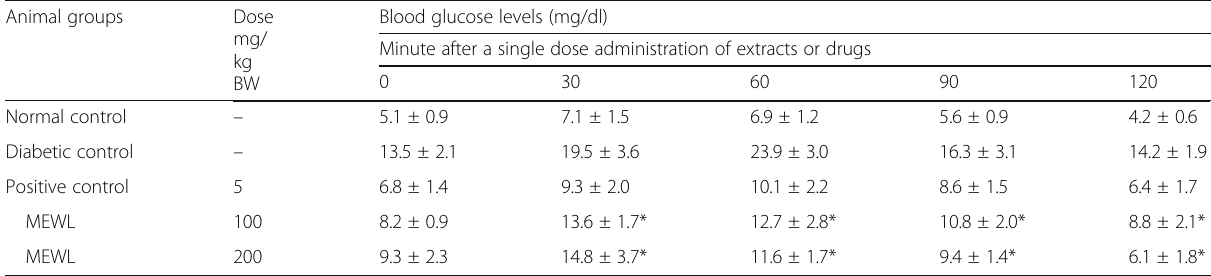
Table 1 Effects of the MEWL on blood glucose levels of diabetic mice in OGTT Animal